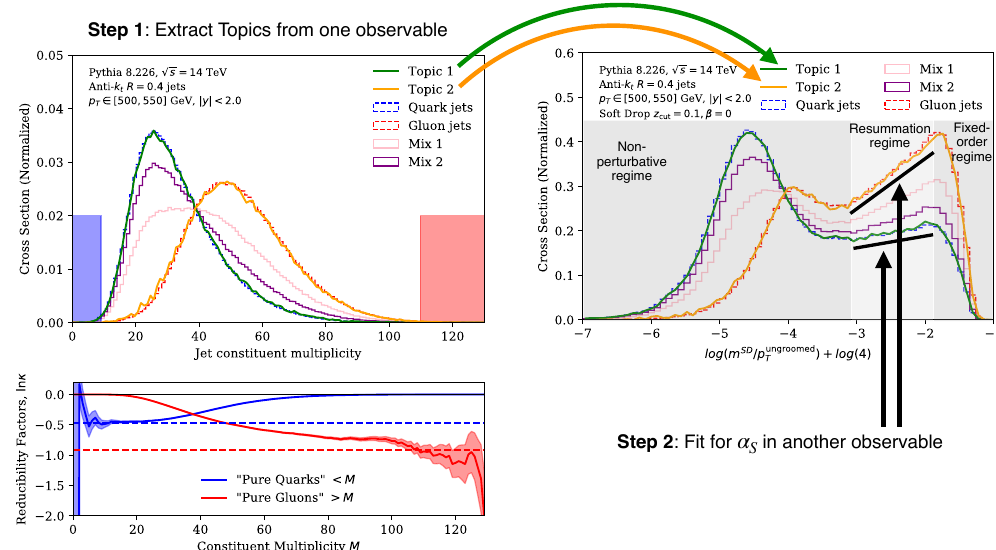
Figure 1 . An overview of the proposed extraction of α S . First (left), the topics are extracted from an approximately mutually irreducible observable. Illustrated above is the case of constituent multiplicity. Two samples with different quark/gluon compositions are used to extract the topics. These topics are interpreted as quarks and gluons and the fractions of the two topics are then used as the quark and gluon fractions. Next (right), an observable with a precisely known cross section is used to fit for α S . We consider the groomed jet mass and focus on the resummation regime at intermediate mass where non-perturbative and fixed-order effects are small. The predictions as a function of α S are then fit to the data, with the proper mixture of the quark and gluon